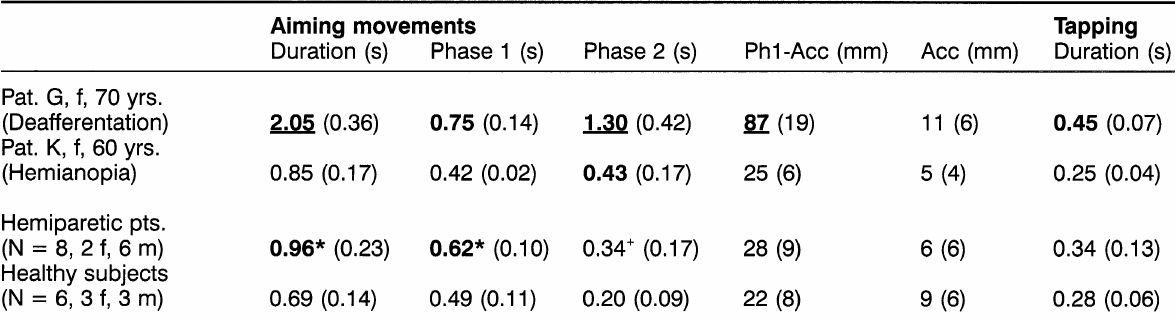
TABLE I. Kinematic parameters for tapping and aiming movements (left arm) at baseline for a deafferented patient and control subjects Aiming movements Tapping Duration (s) Phase 1 (s) Phase 2 (s) Ph1-Acc (mm) Acc (mm) Duration (s) Pat. G, f, 70